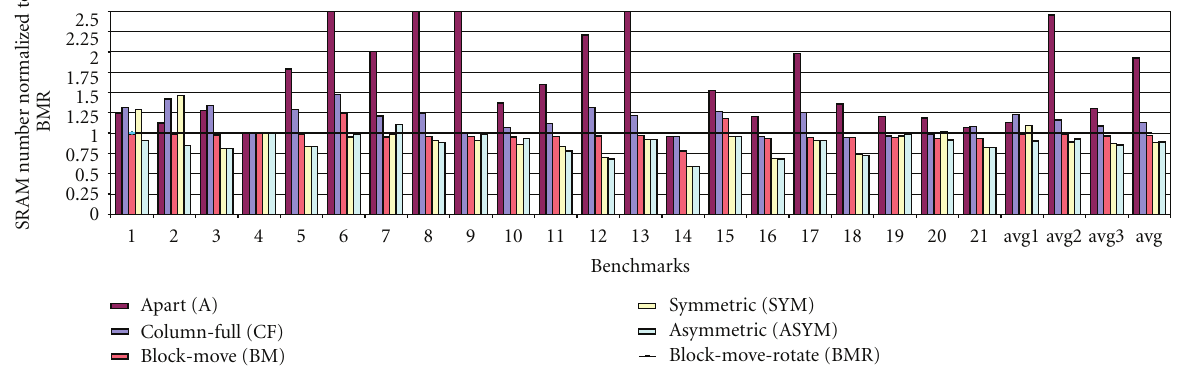
Figure 14: Configuration memory comparison between di ff erent techniques of mesh- and tree-based